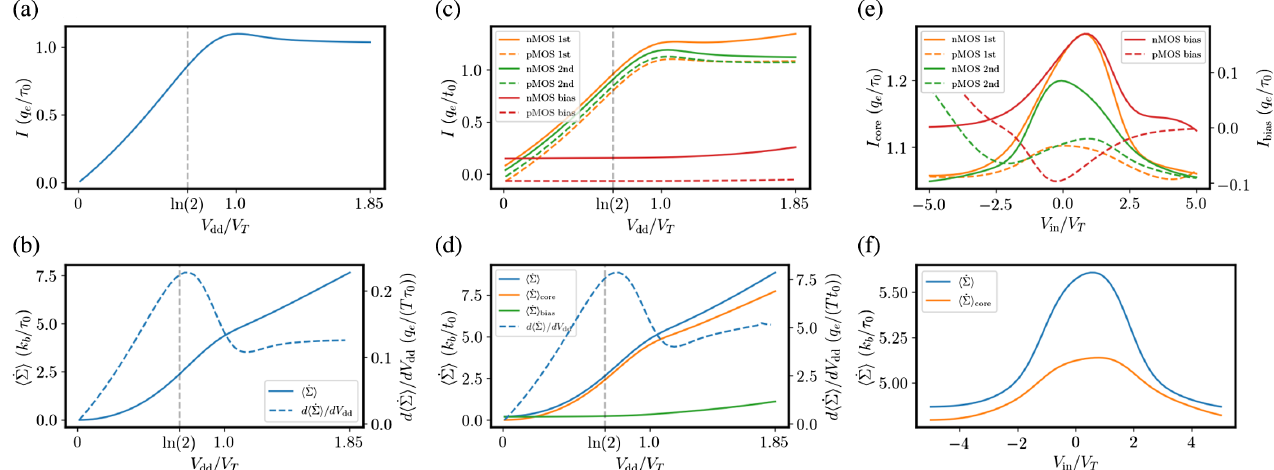
FIG. 15. For the core circuit in Fig. 13(b), we show (a) the average electric current (which is the same for all four transistors) and (b) the total entropy production rate and its derivative with respect to the powering voltage. For the full circuit in Fig. 13(c) with 0 , we show (c) the average electric current through all the transistors and (d) the total entropy production rate and its V V and V b ¼ T in ¼ derivative. In this case, we also split the contributions to the entropy production associated with the transistors of the core and biasing circuits. In (e) and (f), we show, respectively, the average current through all the transistors and the entropy production rate for the full circuit, this time as a function of the input voltage for V 50 aF, C 10 − 2 C C , and n ¼ 1 g ¼ o ¼ g